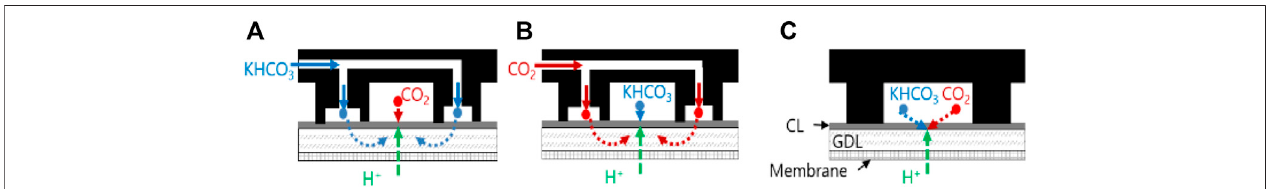
FIGURE 5 | Schematic representation of (A) the dual- fl ow type cell with gas in the main channel [Dual (gas)-A], (B) the dual- fl ow type cell with liquid in the main channel [Dual (liq)-A], and (C) the single-channel type cell [Single (mix)-A].